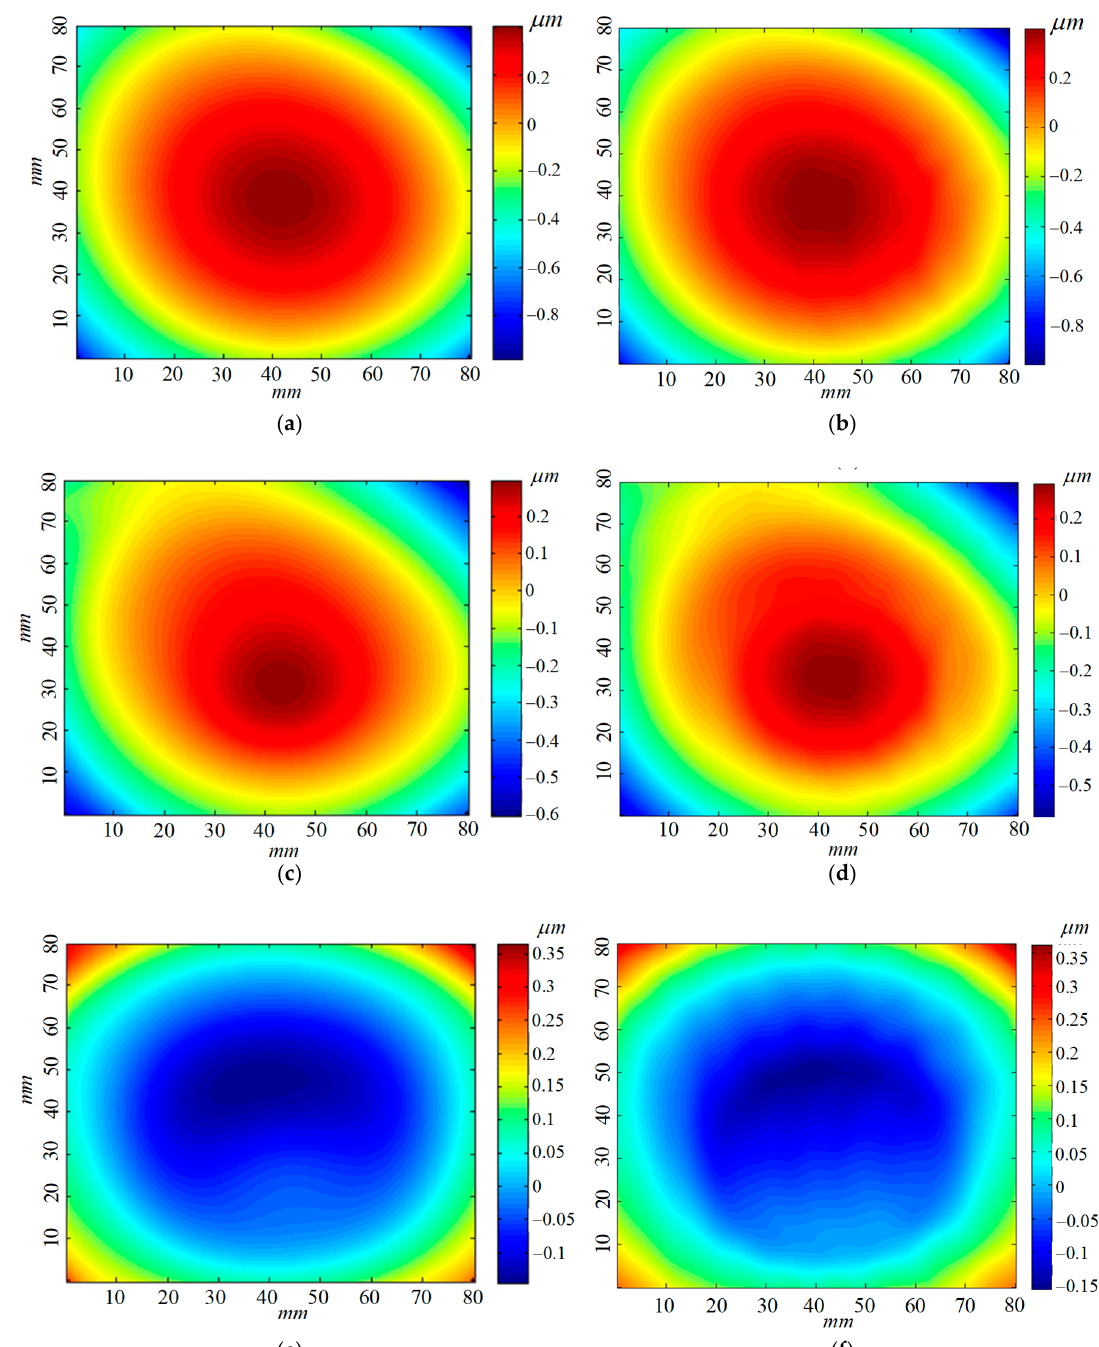
Figure 6. The surface profiles measured with the 36-step algorithm and the ZYGO interferometer. ( a ) The profile of the front surface obtained with the 36-step algorithm; ( b ) the profile of the front surface obtained the ZYGO interferometer; ( c ) the profile of the rear surface obtained with the 36-step algorithm; ( d ) the profile of the rear surface obtained with the ZYGO interferometer; ( e ) the profile of the variation in the thickness obtained with the 36-step algorithm; ( f ) the profile of variation in the thickness obtained with the ZYGO interferometer.